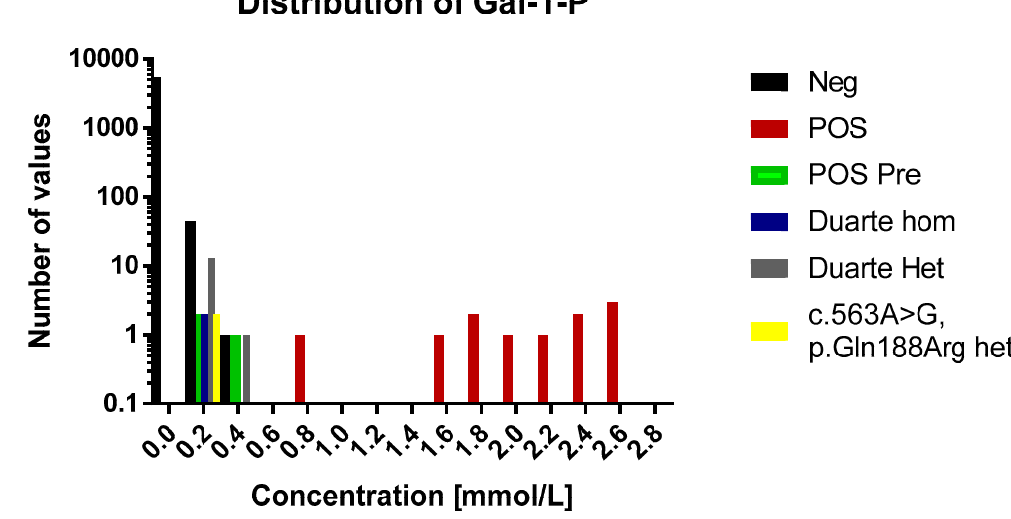
Figure 1. A histogram over the distribution of GAL-1-P results of the study. The histogram is divided into 0.2 mmol/L bins. Each sample category is signified by a separate color. For the sake of easy comparison the y axis is logarithmic in scale. Legend: Neg, negative for galactosaemia; POS, positive for galactosaemia; POS Pre, positive for galactosaemia diagnosed before birth; Duarte Hom, homozygote for Duarte mutation; Duarte Het, heterozygote for Duarte mutation; c. 563A>G, p.Gln 188Arg het, heterozygpte for classical galactosaemia.